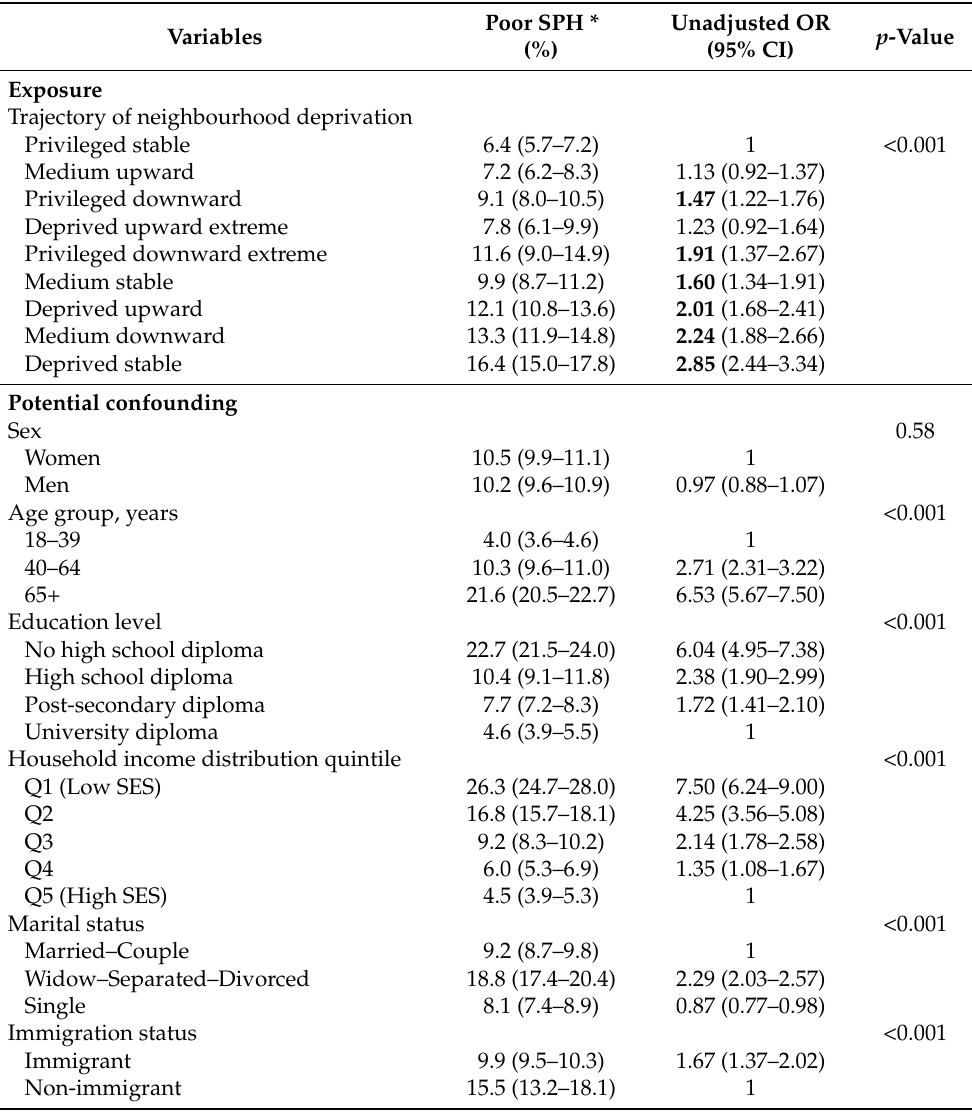
Table 2. Bivariate associations between poor self-perceived health and independent